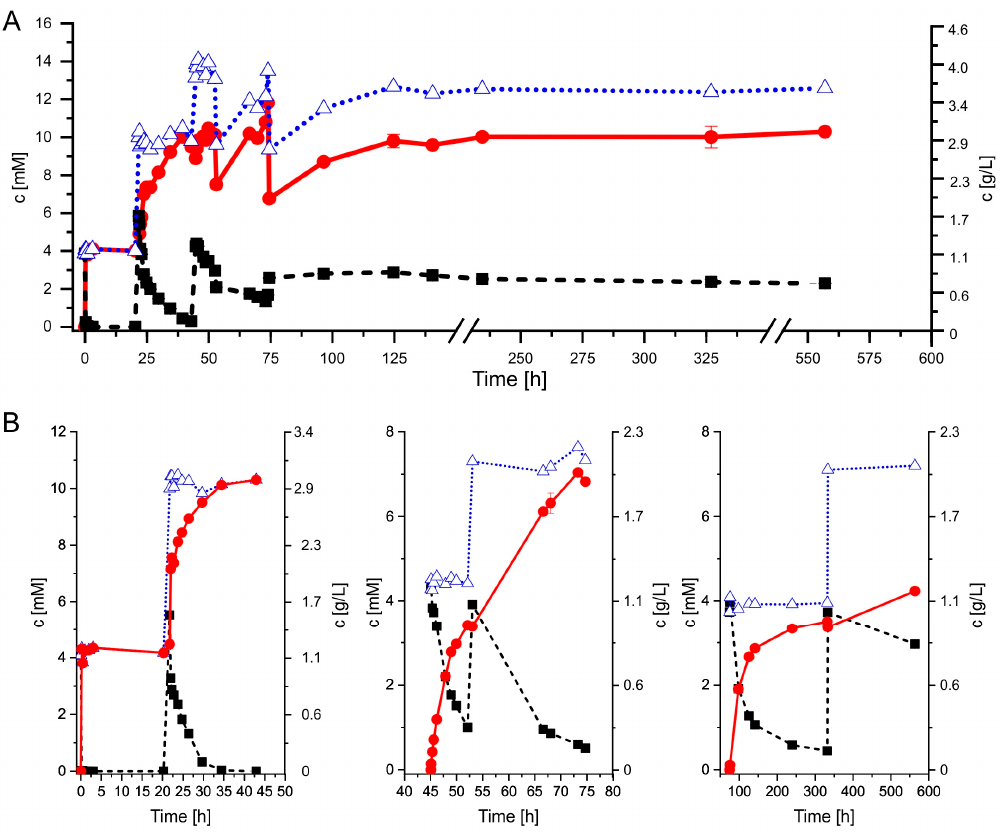
Figure 5. The conversion of AD (black squares) to ADD (red circles), AD + ADD (open blue triangles) by ( A ) homogenous AcmB and ( B ) immobilized AcmB: MCF / GA. The reaction with homogenous AcmB was conducted in one pot fed with the substrate with three portions of AD (4.0, 6.0, 4.2 mM) and one portion of DCPIP at 53 h. The reaction with AcmB: MCF / GA was conducted in three separate reactors in a sequence with one additional AD feed. Table 3. Comparison of fed-batch reaction with homogeneous AcmB and immobilized AcmB:MCF / GA that was reused in three fed-batch reactors. The e ffi ciency of the process was calculated based on the product concentration and the introduced substrate to the